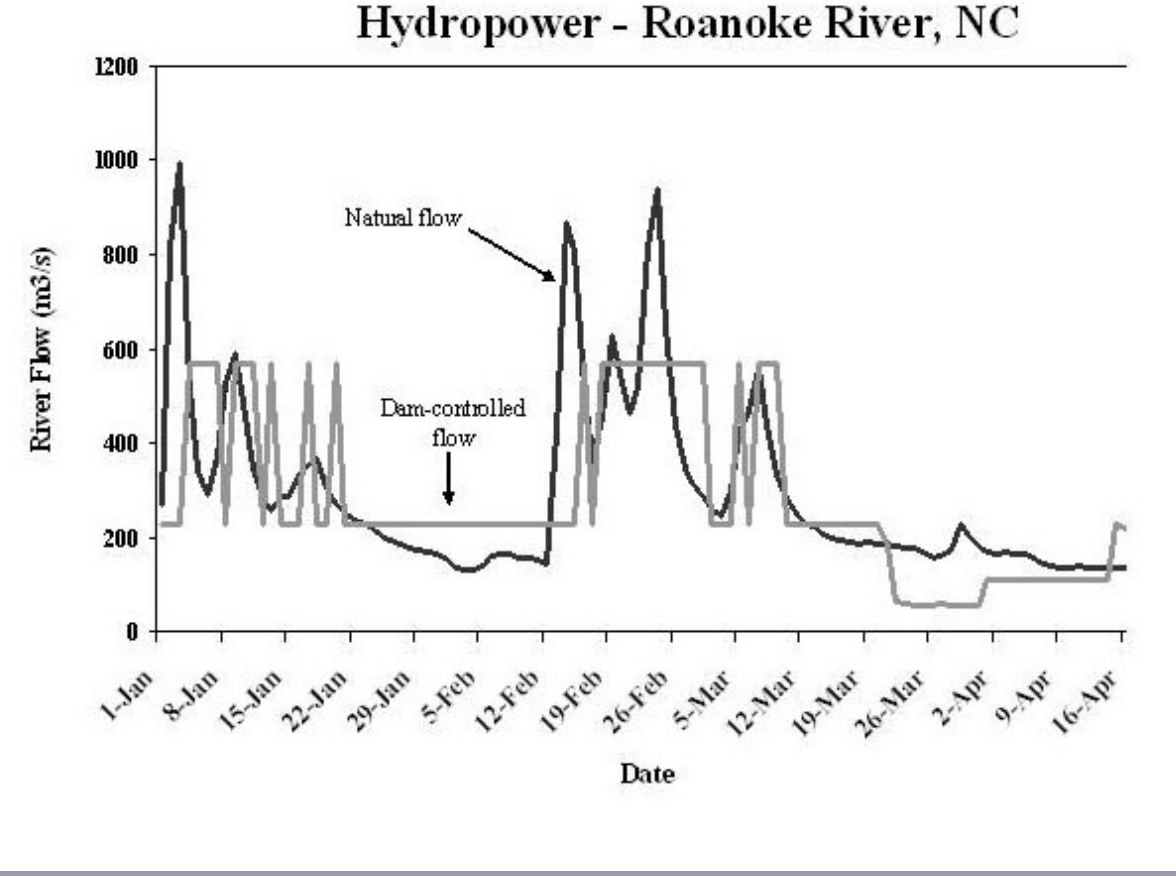
Fig. 2. Operation of a series of dams for hydropower and flood control on the Roanoke River in North Carolina, USA results in lowered flood peaks followed by frequent, short-duration high-flow pulses caused by releases of water from turbines to generate electricity. Note that flows in April drop lower than natural during a period in which dam releases are curtailed to restore reservoir levels (based on 1945